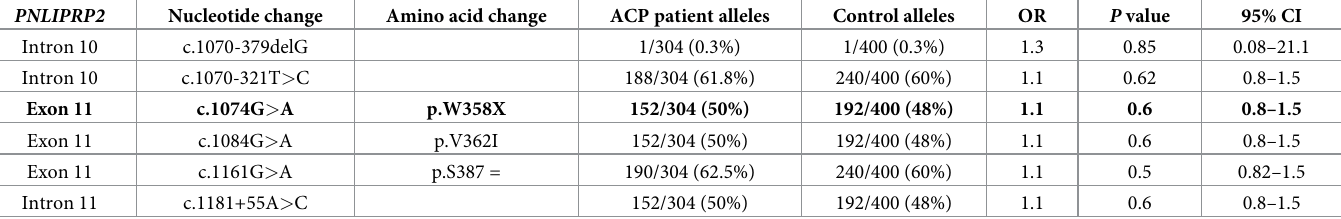
Table 6. Allele frequency of PNLIPRP2 variants in patients with alcoholic chronic pancreatitis (ACP) and controls without pancreatic disease. PNLIPRP2